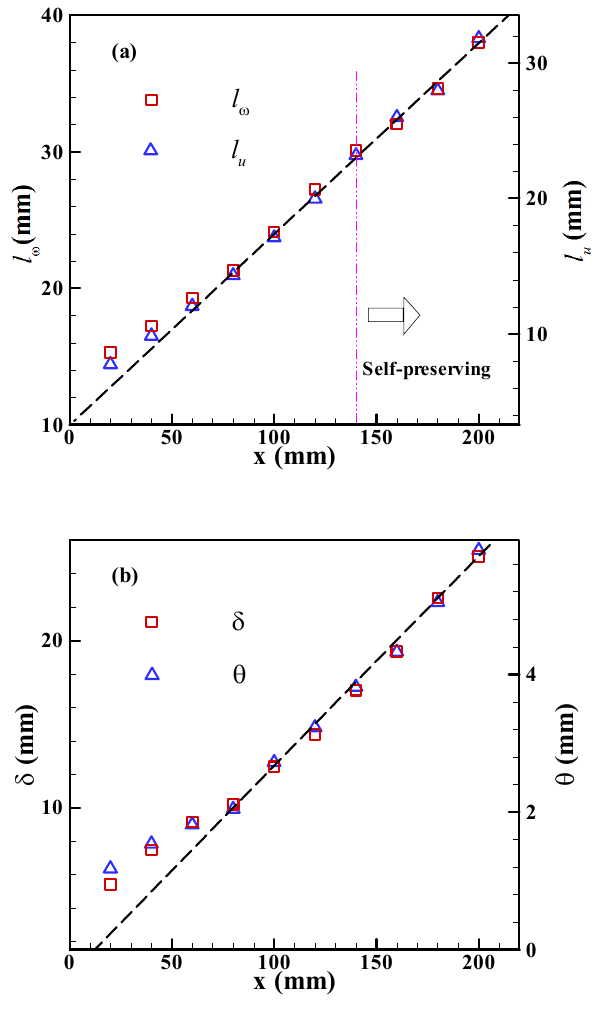
, l and (b) δ , θ under the condition of R = 0.67 and Re u ω